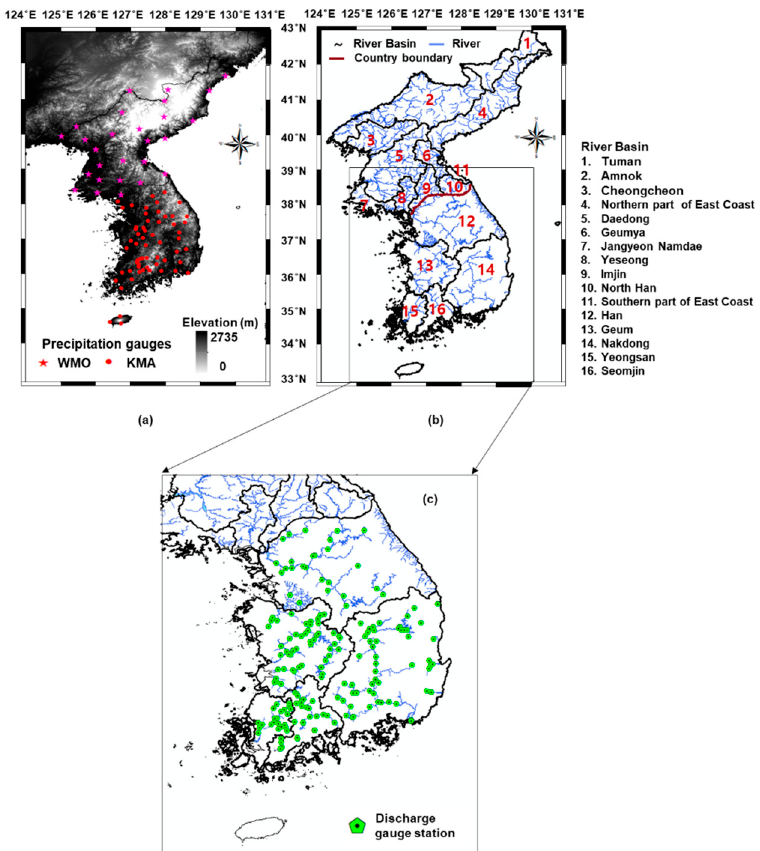
Figure 1. Study area. ( a ) Digital elevation model (DEM) and precipitation gauges and ( b ) major rivers and basin. ( c ) Discharge gauge station in South Korea. WMO: World Meteorological Organization and KMA: Korea Meteorological Administration.